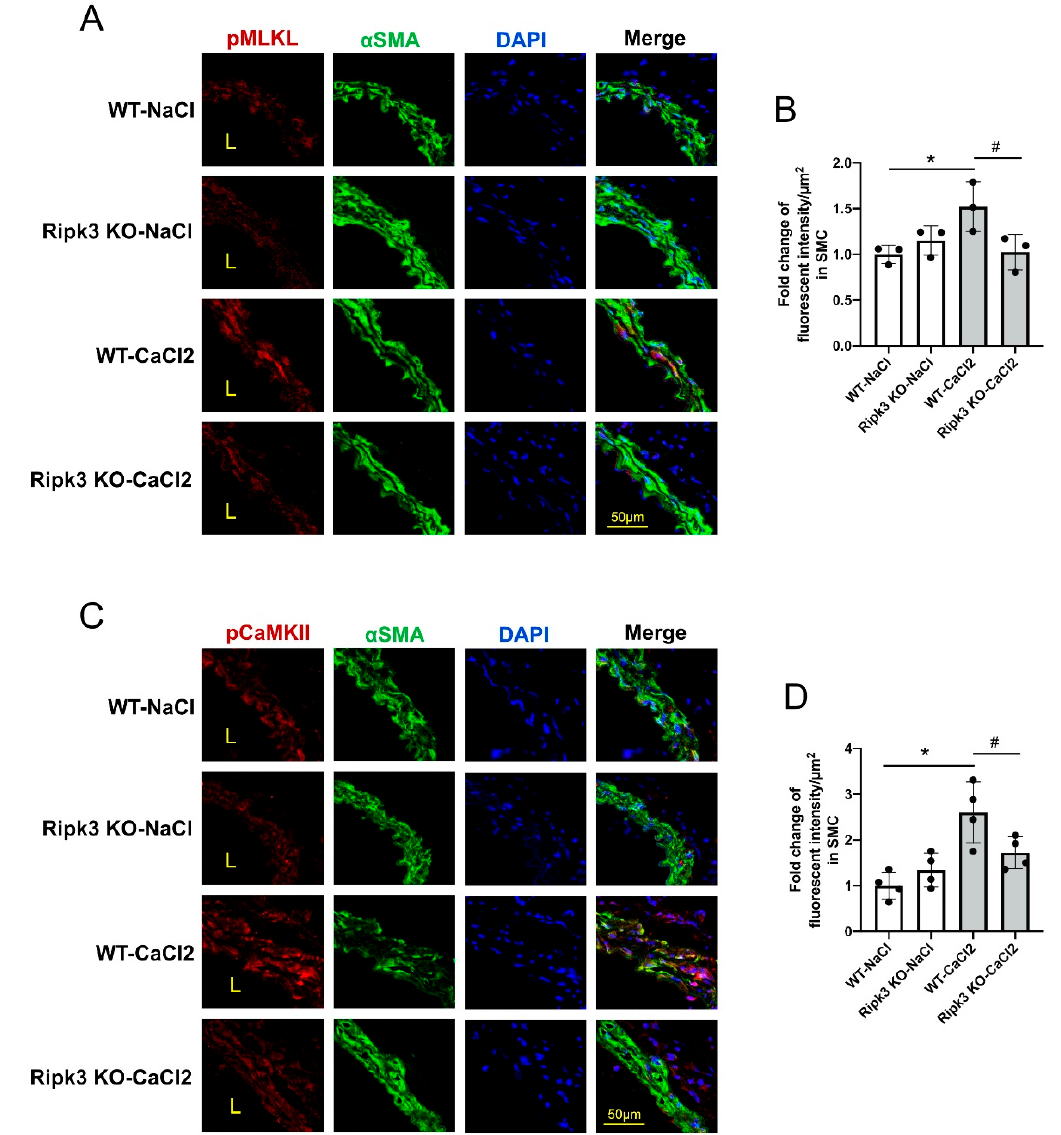
Figure 1. Elevated phosphorylation of MLKL and CaMKII in a murine CaCl 2 -induced AAA model. Ripk3 wildtype (WT) and knockout (KO) mice were subjected to AAA induction by perivascular treatment with CaCl 2 or NaCl (sham group). Four days after AAA induction, treated abdominal aortic segments were harvested for cross sections. ( A , C ) Anti-alpha smooth muscle actin (green) was used to identify medial smooth muscle cells and DAPI was used to stain nuclei. Representative images of immunostaining of phospho-MLKL Ser345 (red) are shown in panel A and phospho-CaMKII Thr287 (red) in panel C. ( B , D ) Quantification of fluorescent intensity of phospho-MLKL Ser345 ( B ) and phospho-CaMKII Thr287 ( D ) is presented relative to the medial layer area. n = 3 and 4 for each group in ( B ) and ( D ), respectively. Data were presented as mean ± SD. One-way ANOVA was performed in ( B ) and ( D ). * p < 0.05, compared with WT NaCl group; # p < 0.05, compared with WT CaCl 2 group.